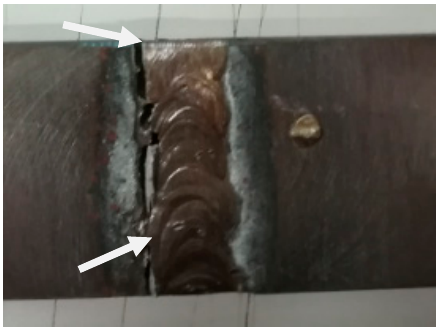
Figure 3. Example of sample failure in the heat-affected zone (HAZ) area found during tensile tests.